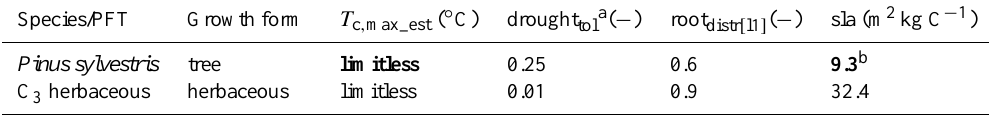
Table 1. Parameter values for LPJ-GUESS. Values for this study are similar to Hickler et al. (2012), Table S1.1, except for values in bold font. T c , max_est represents maximum coldest-month temperature for establishment; drought tol represents drought tolerance level of a species (0 is very tolerant, 1 is not at all tolerant); root distr [ l1 ] is fraction of roots in first soil layer (the remainder being allocated to second soil layer); sla is specific leaf area. Growth form T c , max_est ( ◦ C) drought tola ( − ) root distr [ l1 ] ( − ) sla (m 2 kg C − 1 )